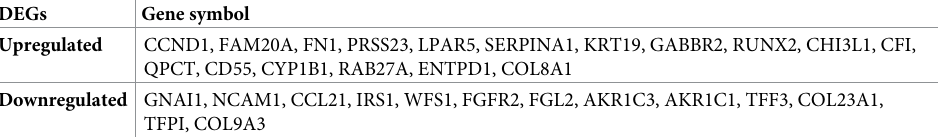
Table 2. Selection of 30 central genes from PPI network, including 17 upregulated and 13 downregulated genes, by using the STRING and Cytoscape software. DEGs Gene symbol